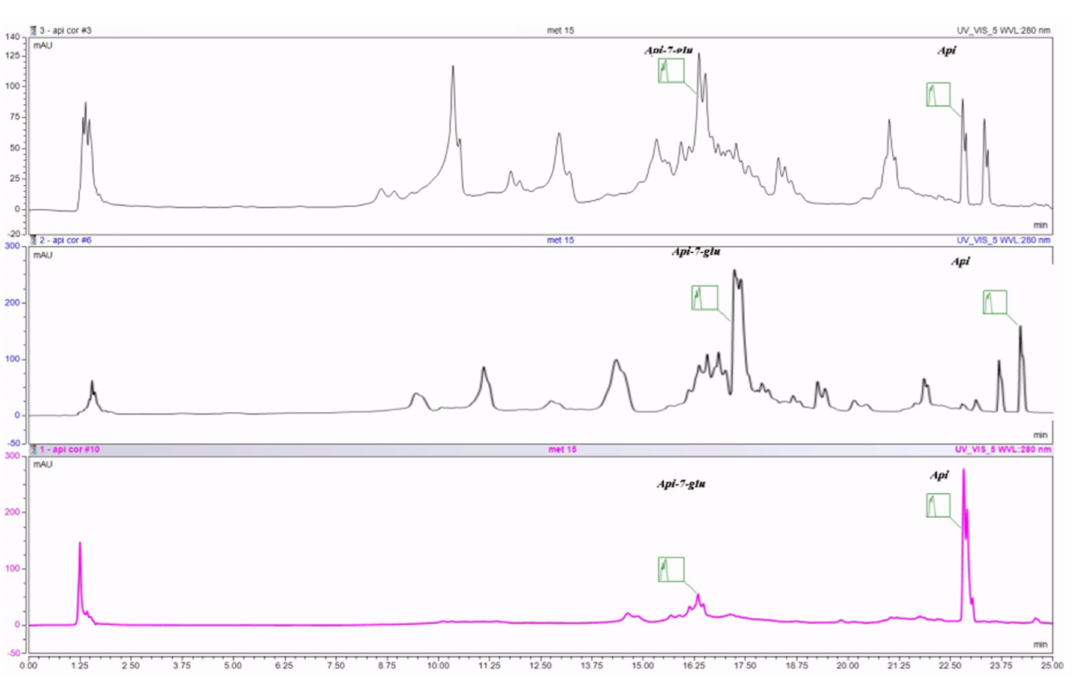
Figure 1. UHPLC chromatogram of the investigated extracts: MC—chamomile flower extract, C- celery seeds extract, P—parsley seeds extract; Api-7-glu—apigenin glucoside,